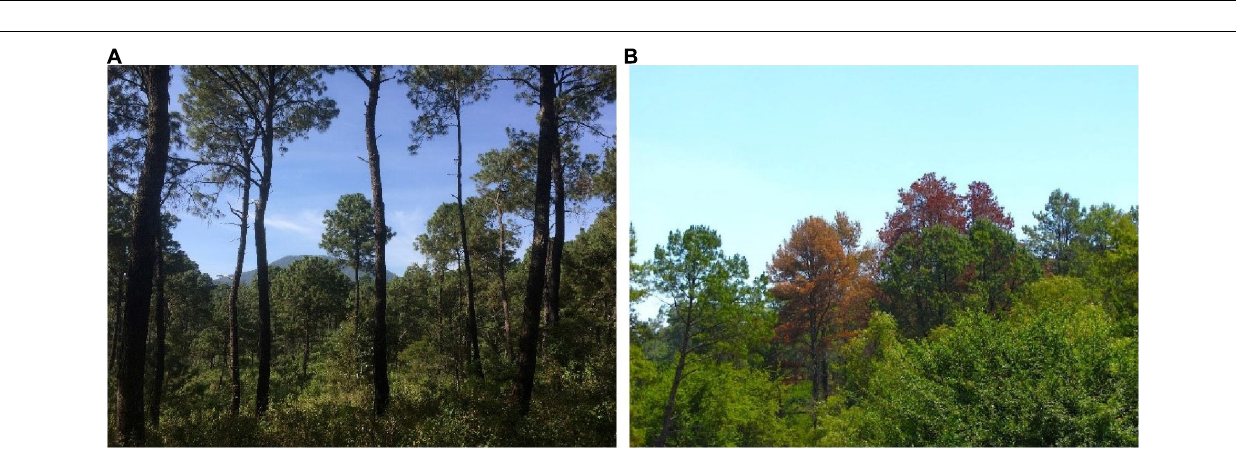
FIGURE 4 | (A) Healthy Pine/Oak forest in Sierra del Tigre, Jalisco. (B) Dead pine trees ( Pinus spp.) infected by Dendroctonus spp. in Sierra del